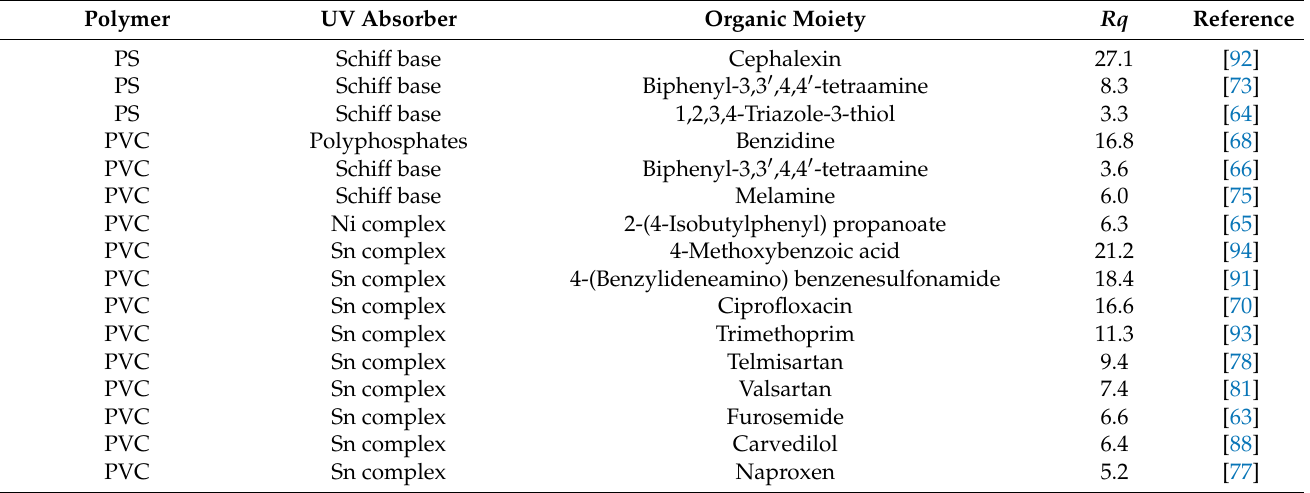
Figure 13. SEM image of the surface of an irradiated PS film in the absence of any additive. Atomic force microscopy (AFM) was used as a tool to measure the effectiveness of UV absorbers towards the stabilization of polymers [115–117]. The roughness factor ( Rq ) for the surface of the blank, irradiated polymers was always high compared with those obtained for the films blended with additives. Such an observation is evidence for the important role played by additives in stabilizing polymers upon irradiation. Highly aromatic (due to the resonance effect) UV additives that contain heteroatoms (due to coordination with the polymeric chain of PVC, for example) showed the most desirable stabilizing effect (Table 2). Table 2. Reduction in the roughness factor Rq (by fold) of polymers in the presence of UV absorbers.